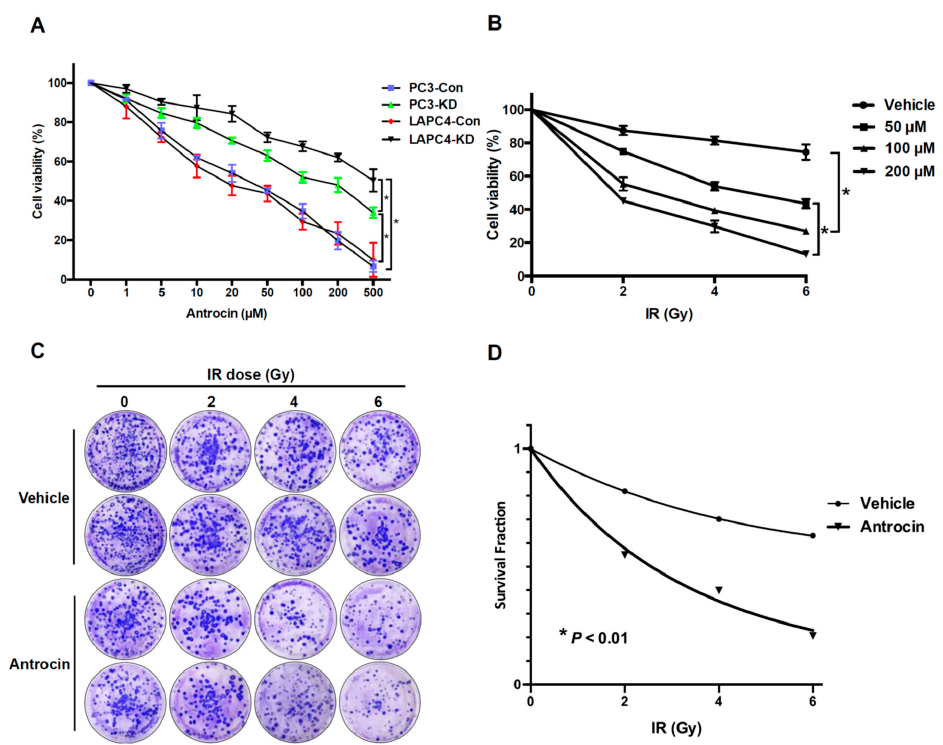
Figure 1. Antrocin inhibits PCa cells proliferation and sensitizes PCa cells to IR-induced cell